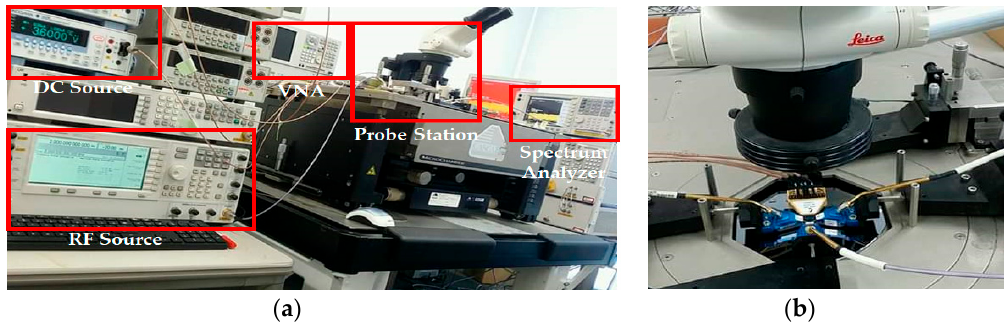
Figure 10. ( a ) Measurement setup; and ( b ) probing situation of the proposed CMOS PA